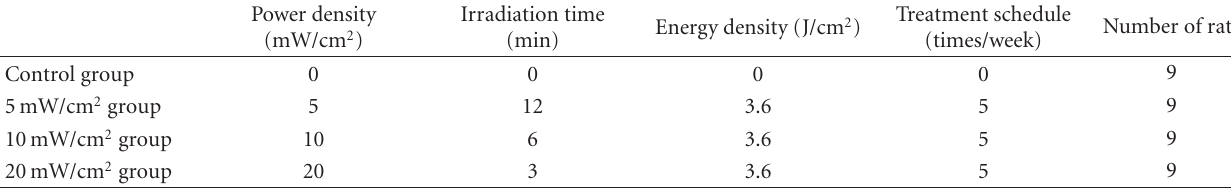
Table 1: Groups of experiment and treatment